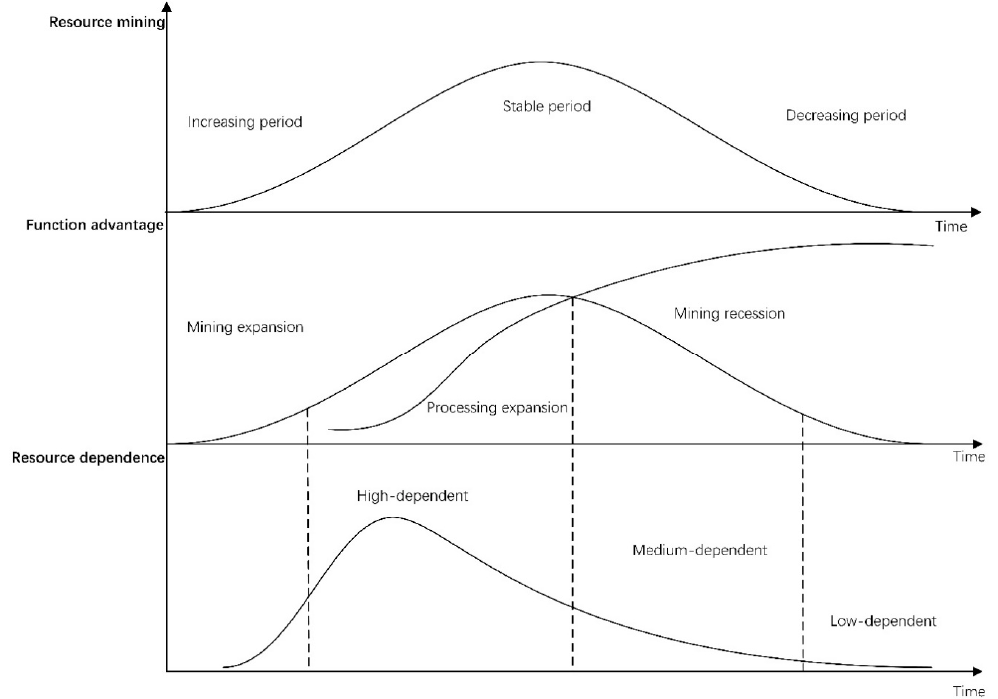
Figure 1. The general evolution process of the relationship between resource dependence (RD) and city function advantage.